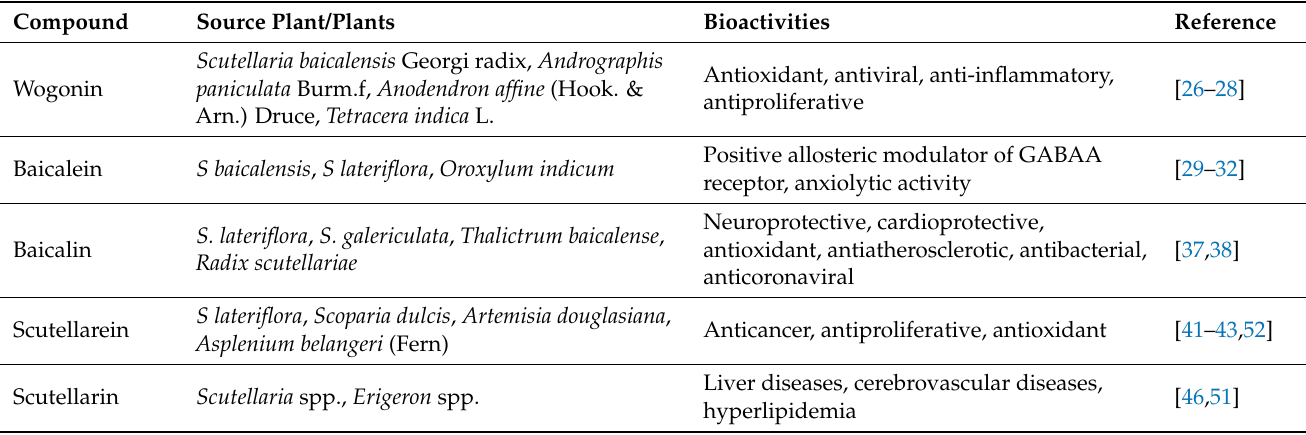
Table 1. An overview of the main features of wogonin, baicalein, baicalin, scutellarein and scutellarin.